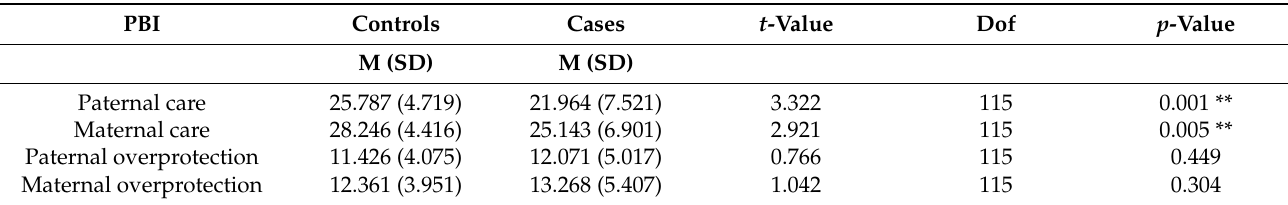
Table 2. The t -test cases vs.